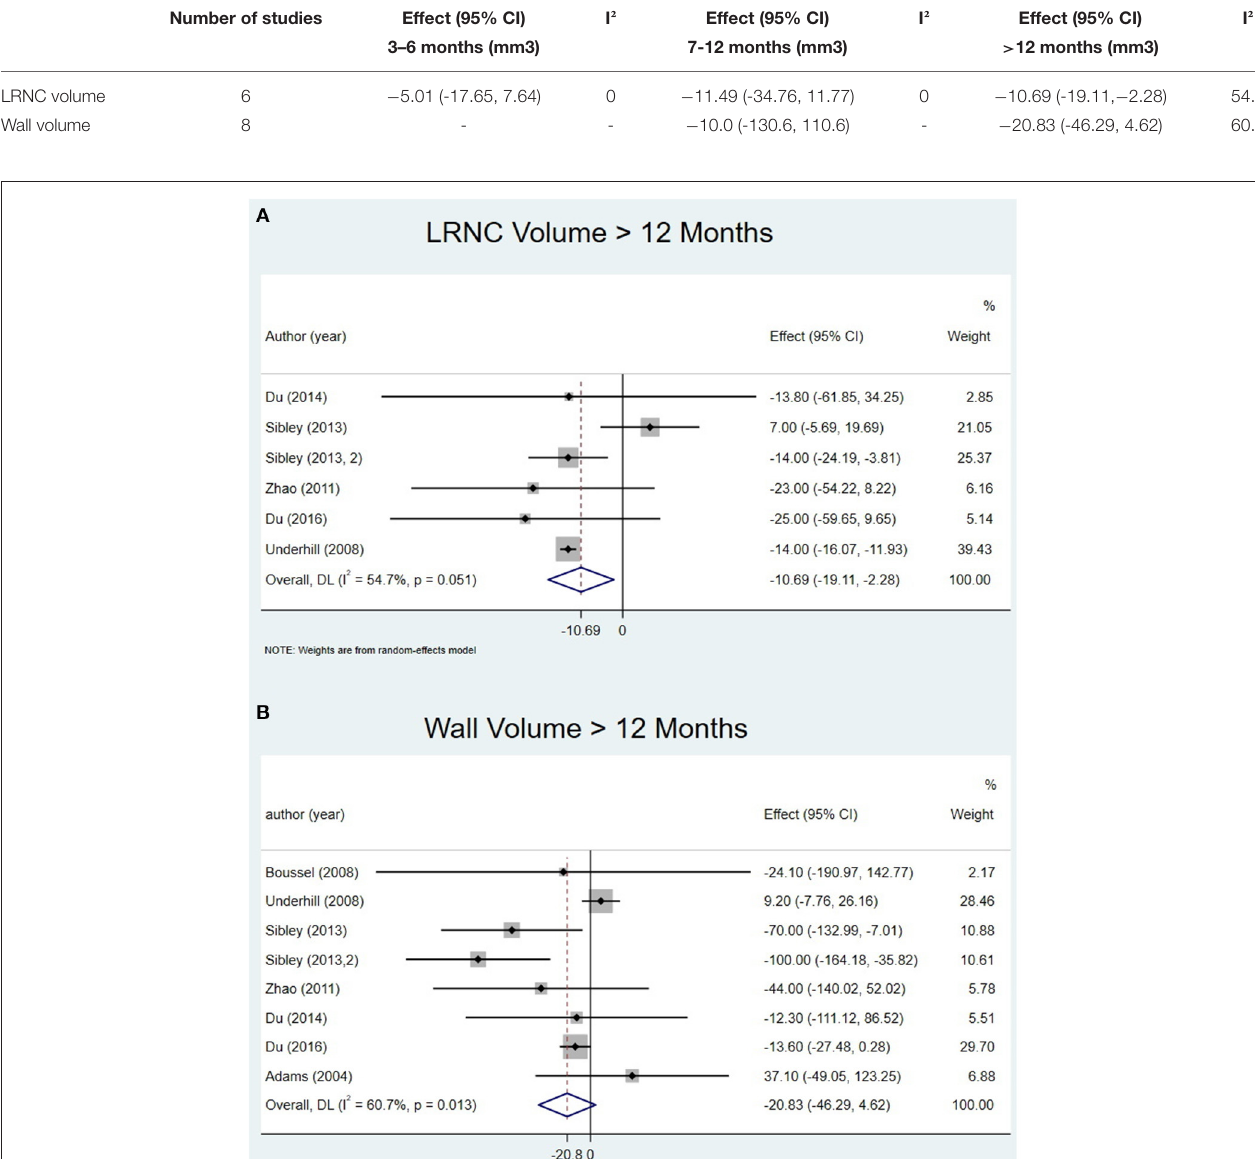
TABLE 3 | Results of meta-analysis.